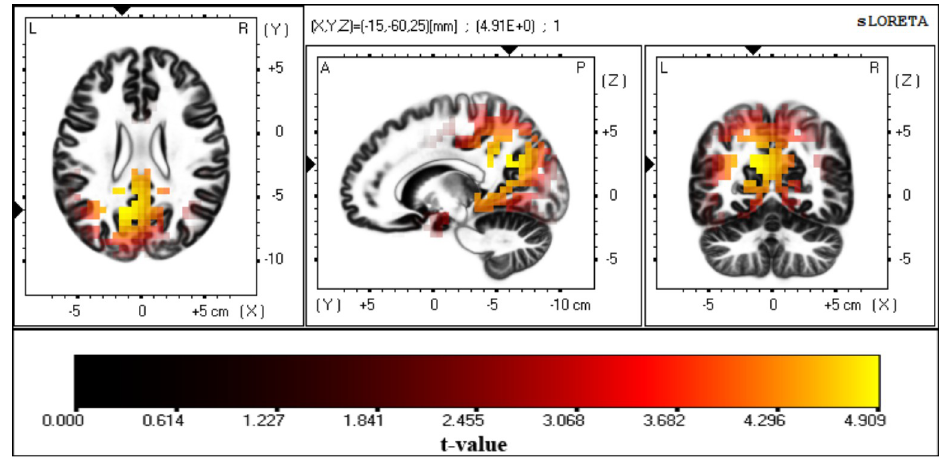
Fig 5. Source localization of the P300. Images show the anatomical estimation of unthresholded P300 sources from the LORETA solution using a single group t -test with 5000 randomizations. Maximum significance was observed over the precuneus and posterior cingulate cortex ( t -value > 4.47 = p <